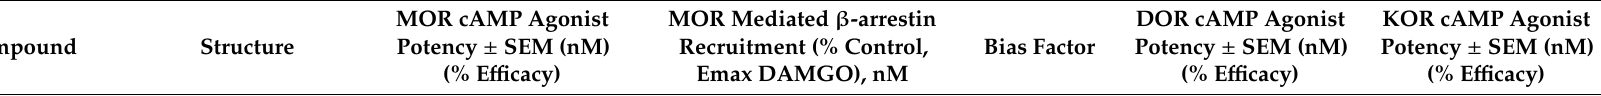
Table 2. Opioid Receptor Activity Measured in the Forskolin-induced cAMP Accumulation Assay a.